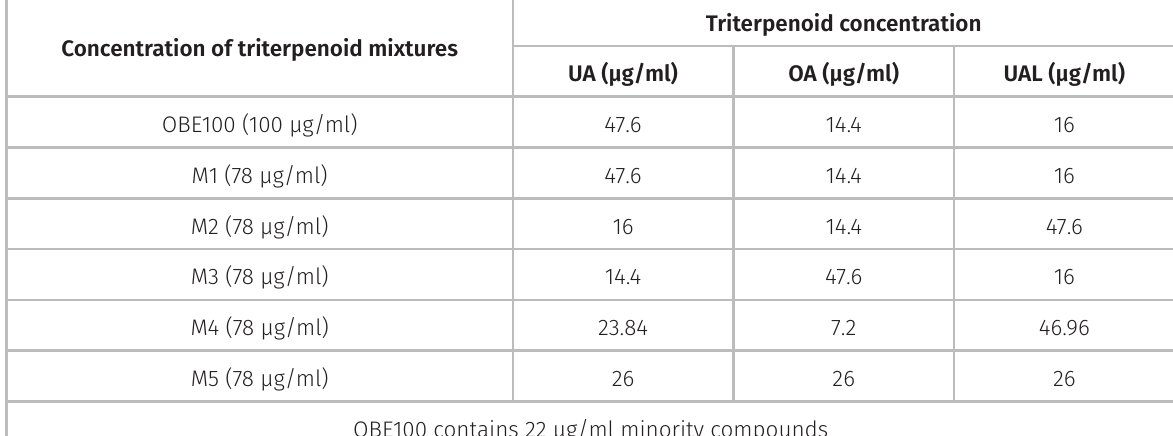
Table I. Combination of triterpenoids to evaluate (OBE100 100 µg/ml).